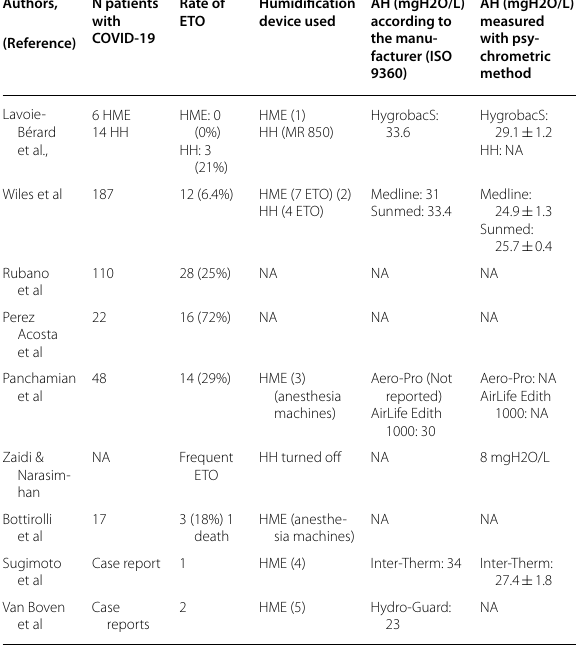
Table: Studies reporting endotracheal tube occlusions in COVID-19 patients. Rate of endotracheal tube occlusions, type of humidifica- tion device, absolute humidity according to the manufacturer and measured on bench with the psychrometric